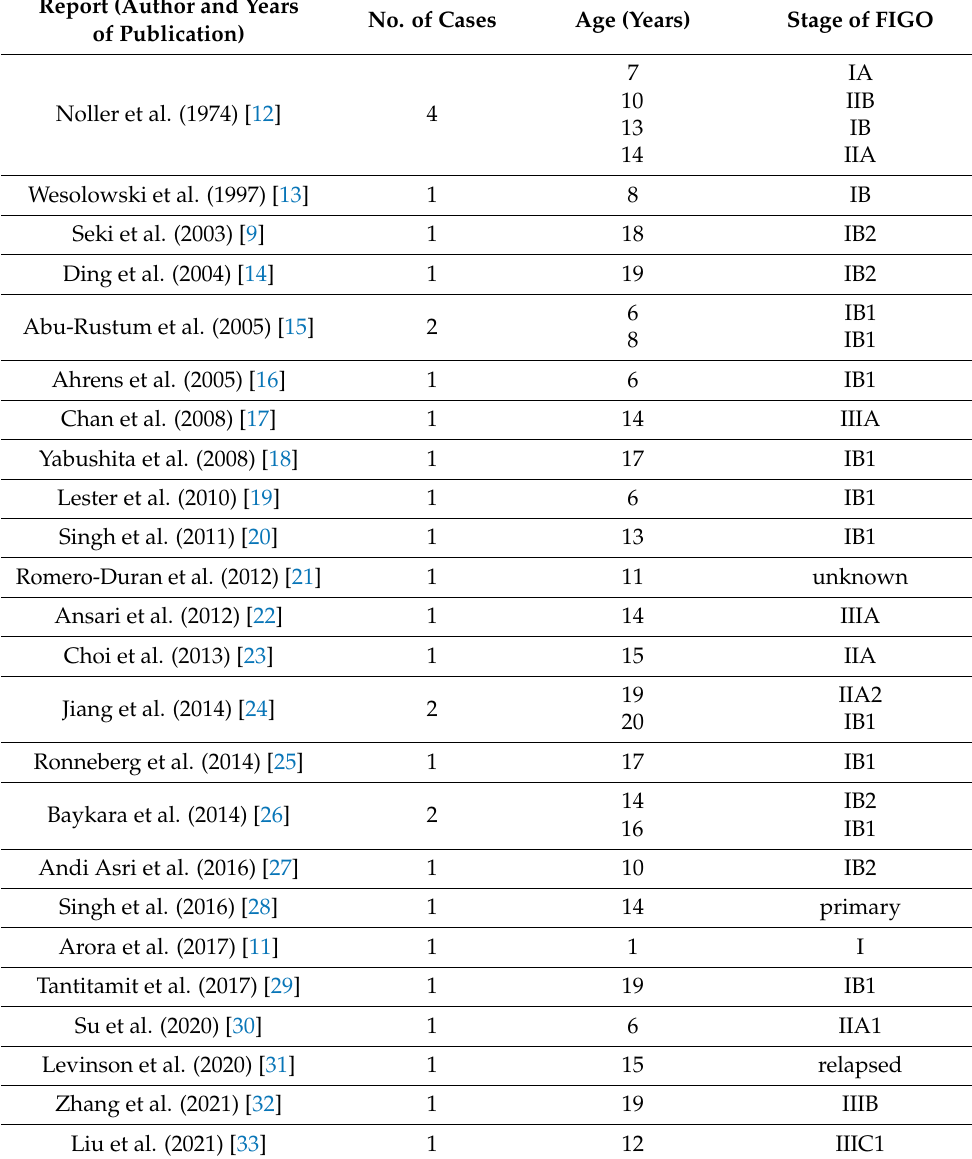
Table 1. Summary of previous reported cases of clear cell adenocarcinoma in teenagers during 1976–2022 (without DES exposure and non-HPV